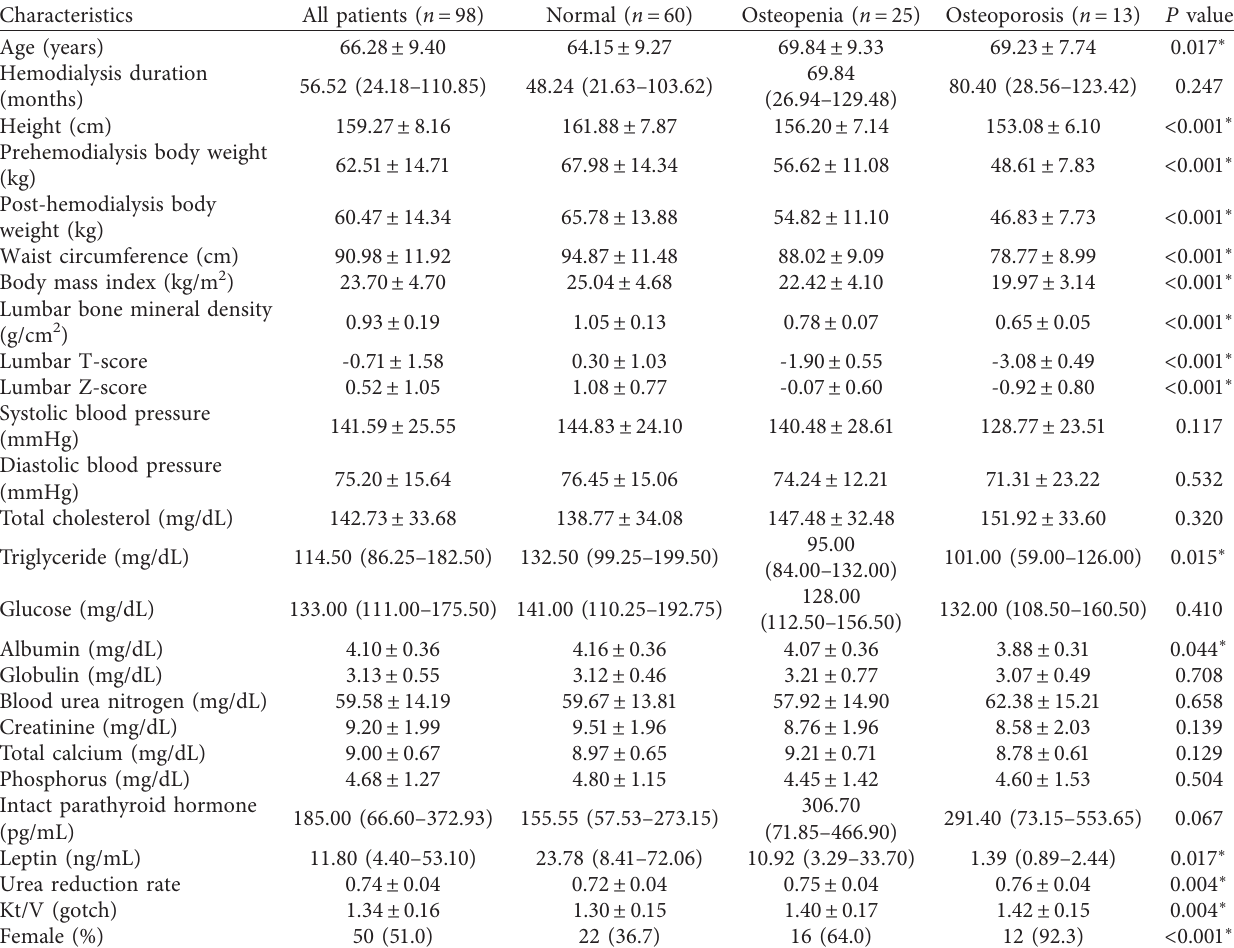
Table 1: Baseline characteristics by categories of bone density in our study.